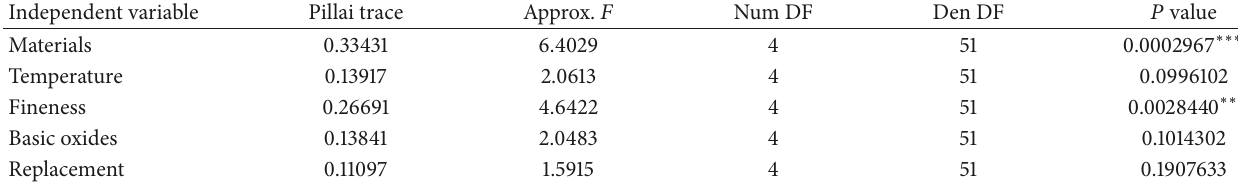
Table 4: The influence of materials, temperature, and chemical composition on initial setting times, final setting times, shrinkage, and soundness.